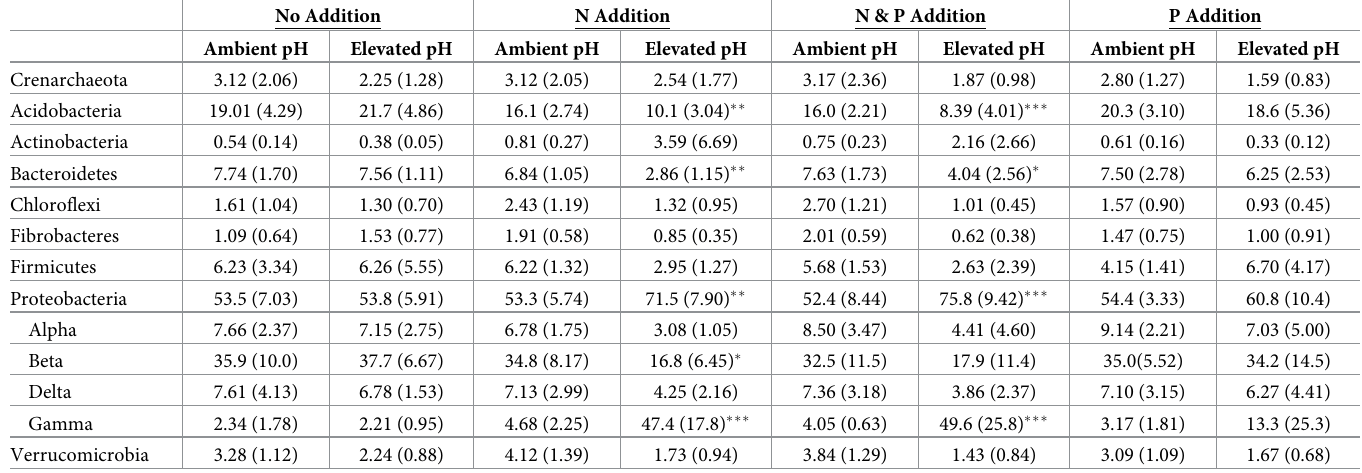
Table 1. Mean percent relative abundance (and standard deviation) of dominant microbial phyla and Proteobacteria classes after 70 day anaerobic incubation. Data represent combined values for 6 and 15˚C temperature treatments as temperature had little effect on overall microbial community composition and Bacteroidetes was the only taxa to have significant temperature response (p = 0.04). Asterisks denote significant difference from the control samples (no addition, ambient pH) deter- mined by Tukey adjusted p-values denoted as ��� , �� , and � for p = 0.001, 0.01, and 0.05,